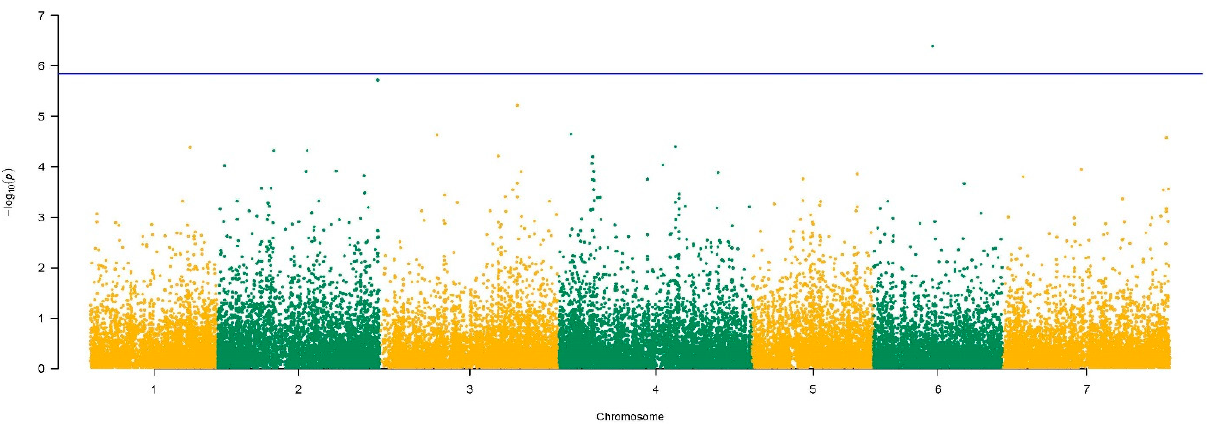
Figure 4. Manhattan plot of GWAS results for CRR using MAGMA. The blue line refers to the Bonferroni correction. On the x -axis, the 7 chromosomes are reported in alternating colours. Table 4. Genes associated with CRR identified using MAGMA ( − log 10 ( p -value) > 4.0). Chromosome number (Chr); Gene coordinate (bp) on the chromosome (Start and Stop); numbers of SNPs detected within the gene sequence (N SNP); p -value for the association of the genes with the CRR ( p -value).